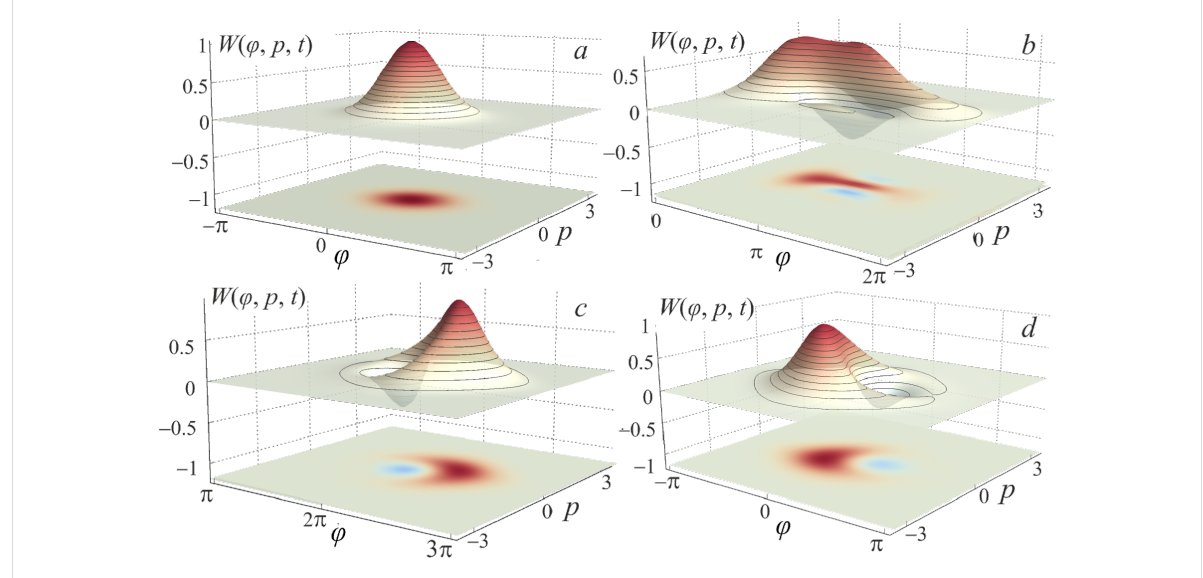
Figure 7: Evolution of the Wigner function of the S Q neuron with l = 2.5 initialized in the ground state under the action of the input flux φ in at the moments t = 0 (absence of φ in ) (a); t = 500 (the middle of the increase of φ in ) (b); t = 1000 (the plateau of φ in ) (c); t = 2000 (absence of φ in ) (d). The input flux parameters are equal to those shown in Figure